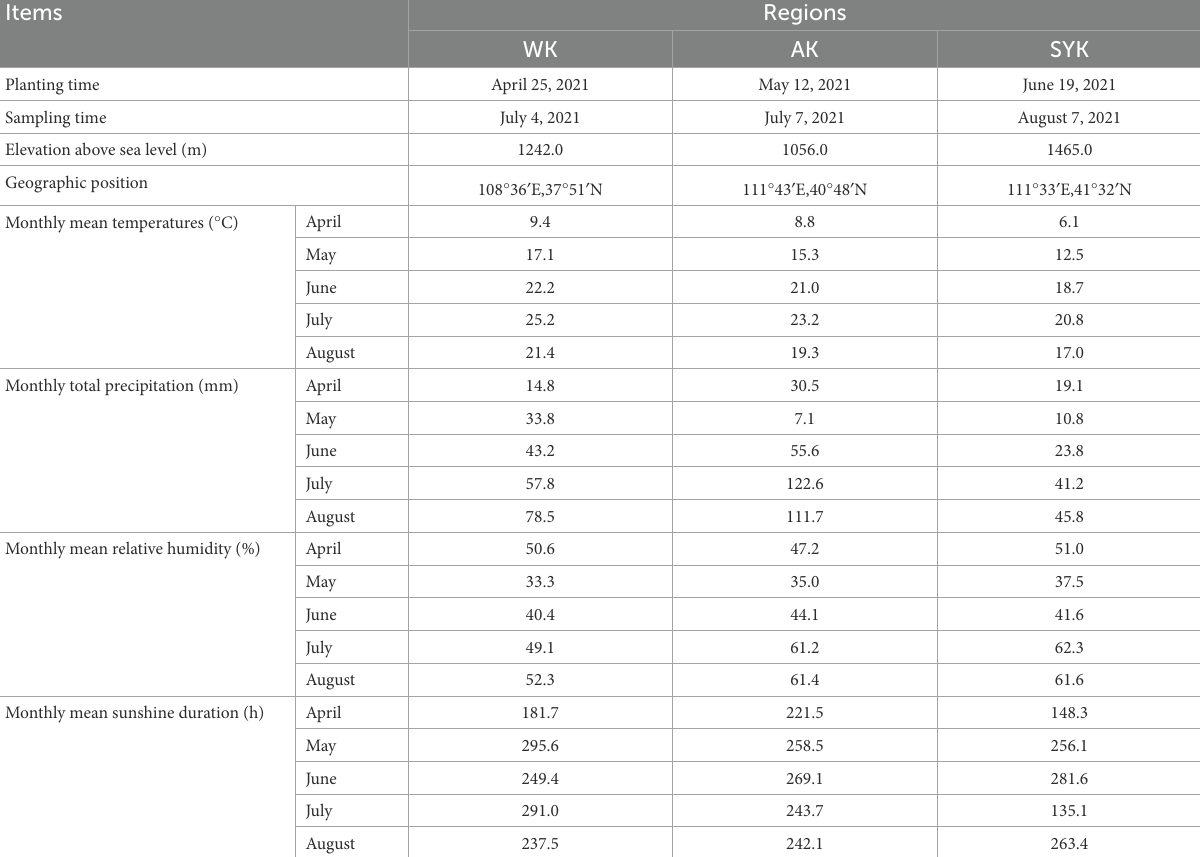
TABLE 1 Sampling time and the basic general situation of sample